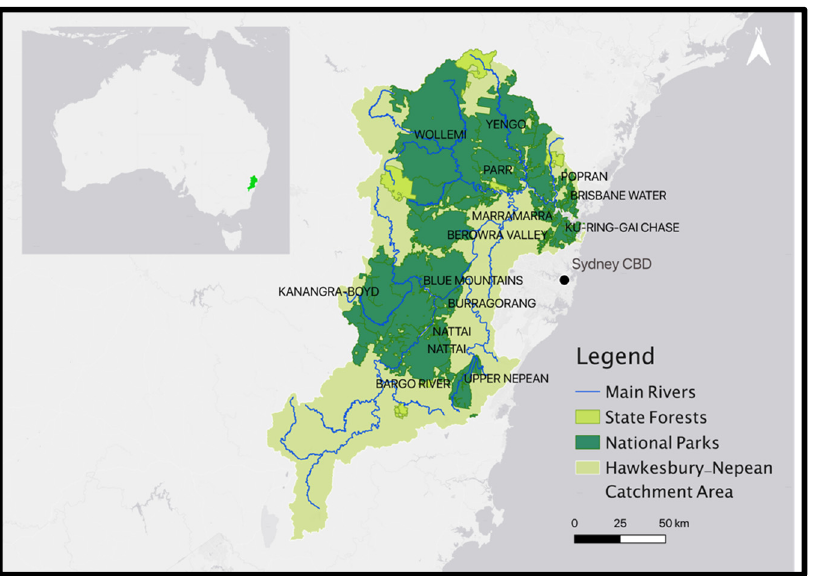
Figure 1. Australia’s Hawkesbury-Nepean Catchment, with the approximate area of the floodplain annotated (generated using QGIS 3.24 software).